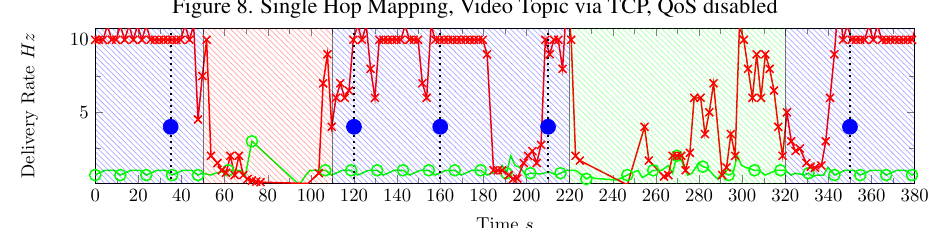
Figure 8. Single Hop Mapping, Video Topic via TCP, QoS disabled